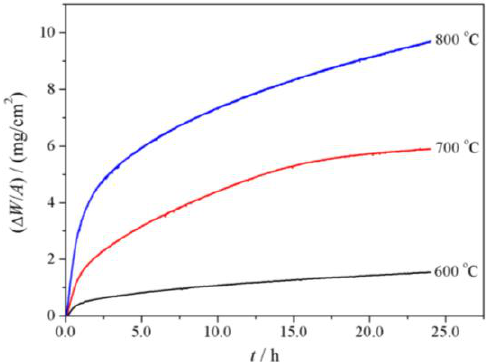
Figure 5. Oxidation kinetics of P92 steel in pure